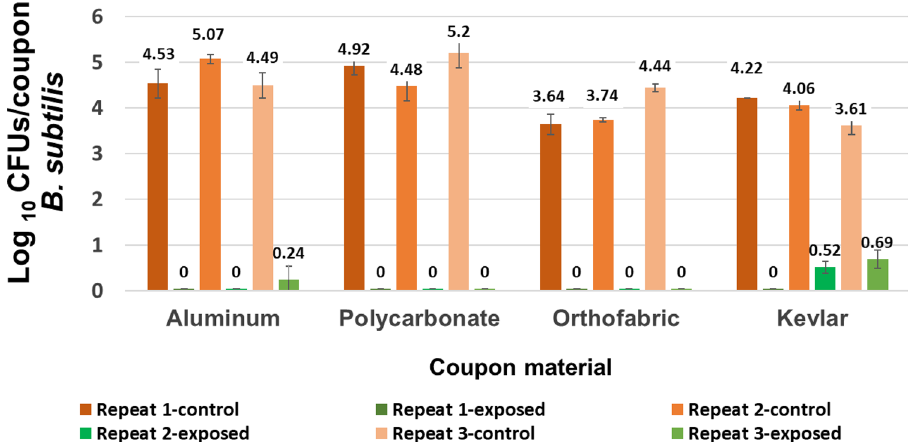
Figure 11. Data showing bacterial population of B. subtilis (CFUs/coupon) in exposed coupons (averaged over 11 coupons placed inside the APS) and control coupons (averaged over 3 coupons placed outside the APS) for four coupon materials, each repeated three times. Complete killing (4 to 5 log reduction) was achieved in most cases using 6 CPPRs and exposures of 30 min (25 min CPPR on + 5 min CPPR off).